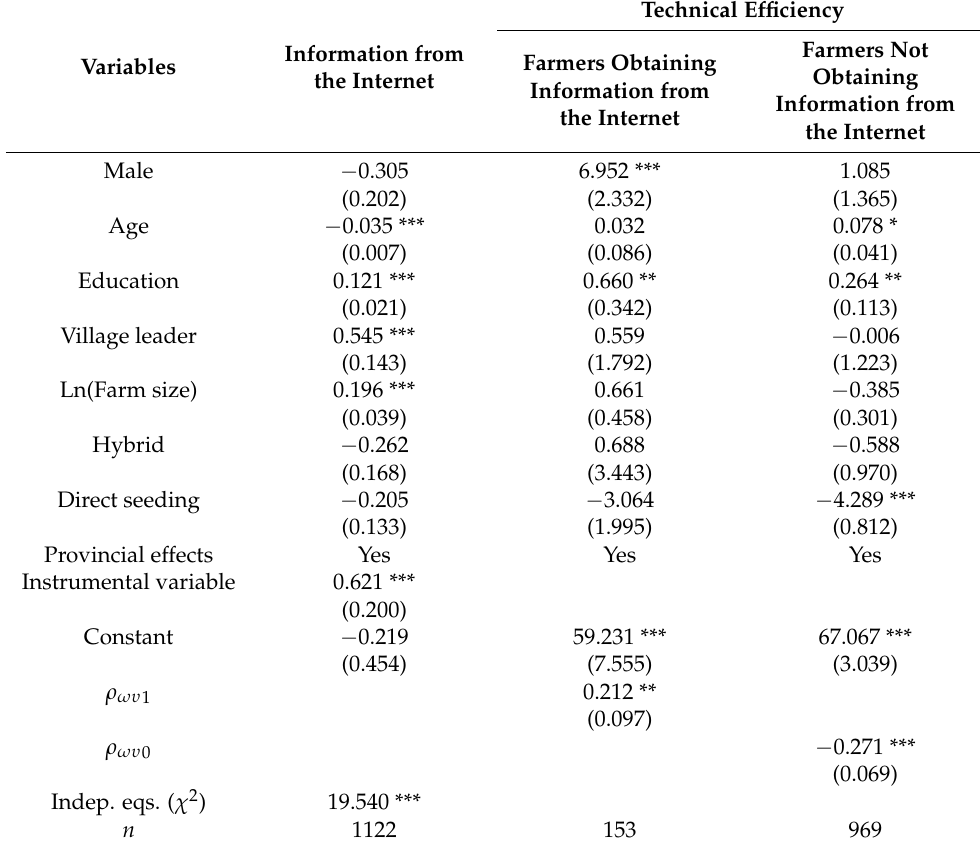
Table 5. Estimation results of the endogenous switching regression